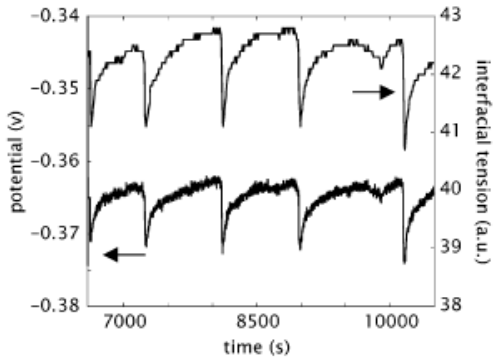
Figure 8: Simultaneous measurement of the electrical potential and interfacial tension in the liquid membrane system composed of aqueous solution of CTAB, 5 mM, and butanol, 0.4 M, (donor phase), 3 mM solution of picric acid in dichloromethane (membrane phase) and aqueous solution of sucrose, 0.1 M, (acceptor phase). Reprinted with permission from [37]. Copyright 2004 American Chemical